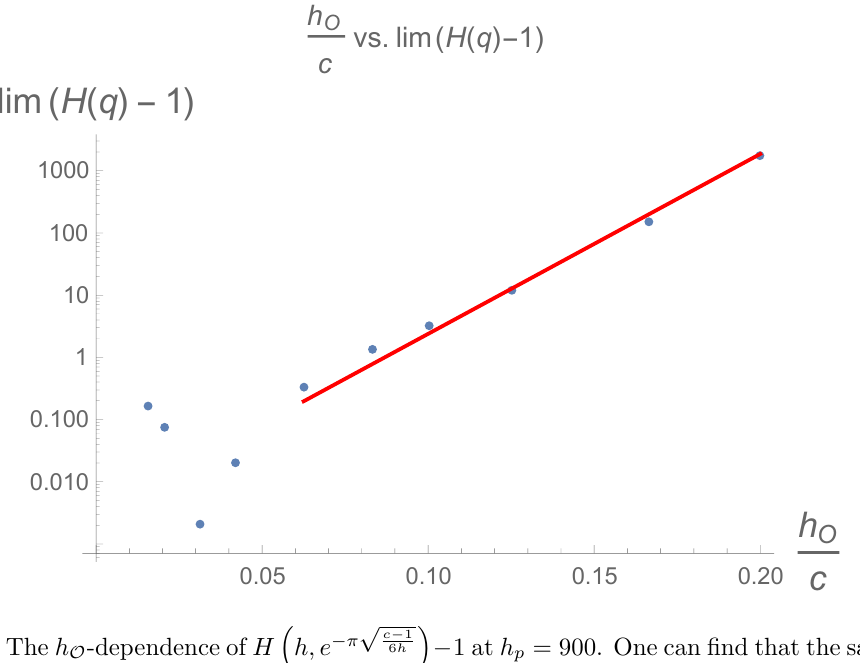
Figure 9 . The h O -dependence of H value H shows a linear dependence on h 0 explained from the results in [51, 52]. The veritcal axis is in